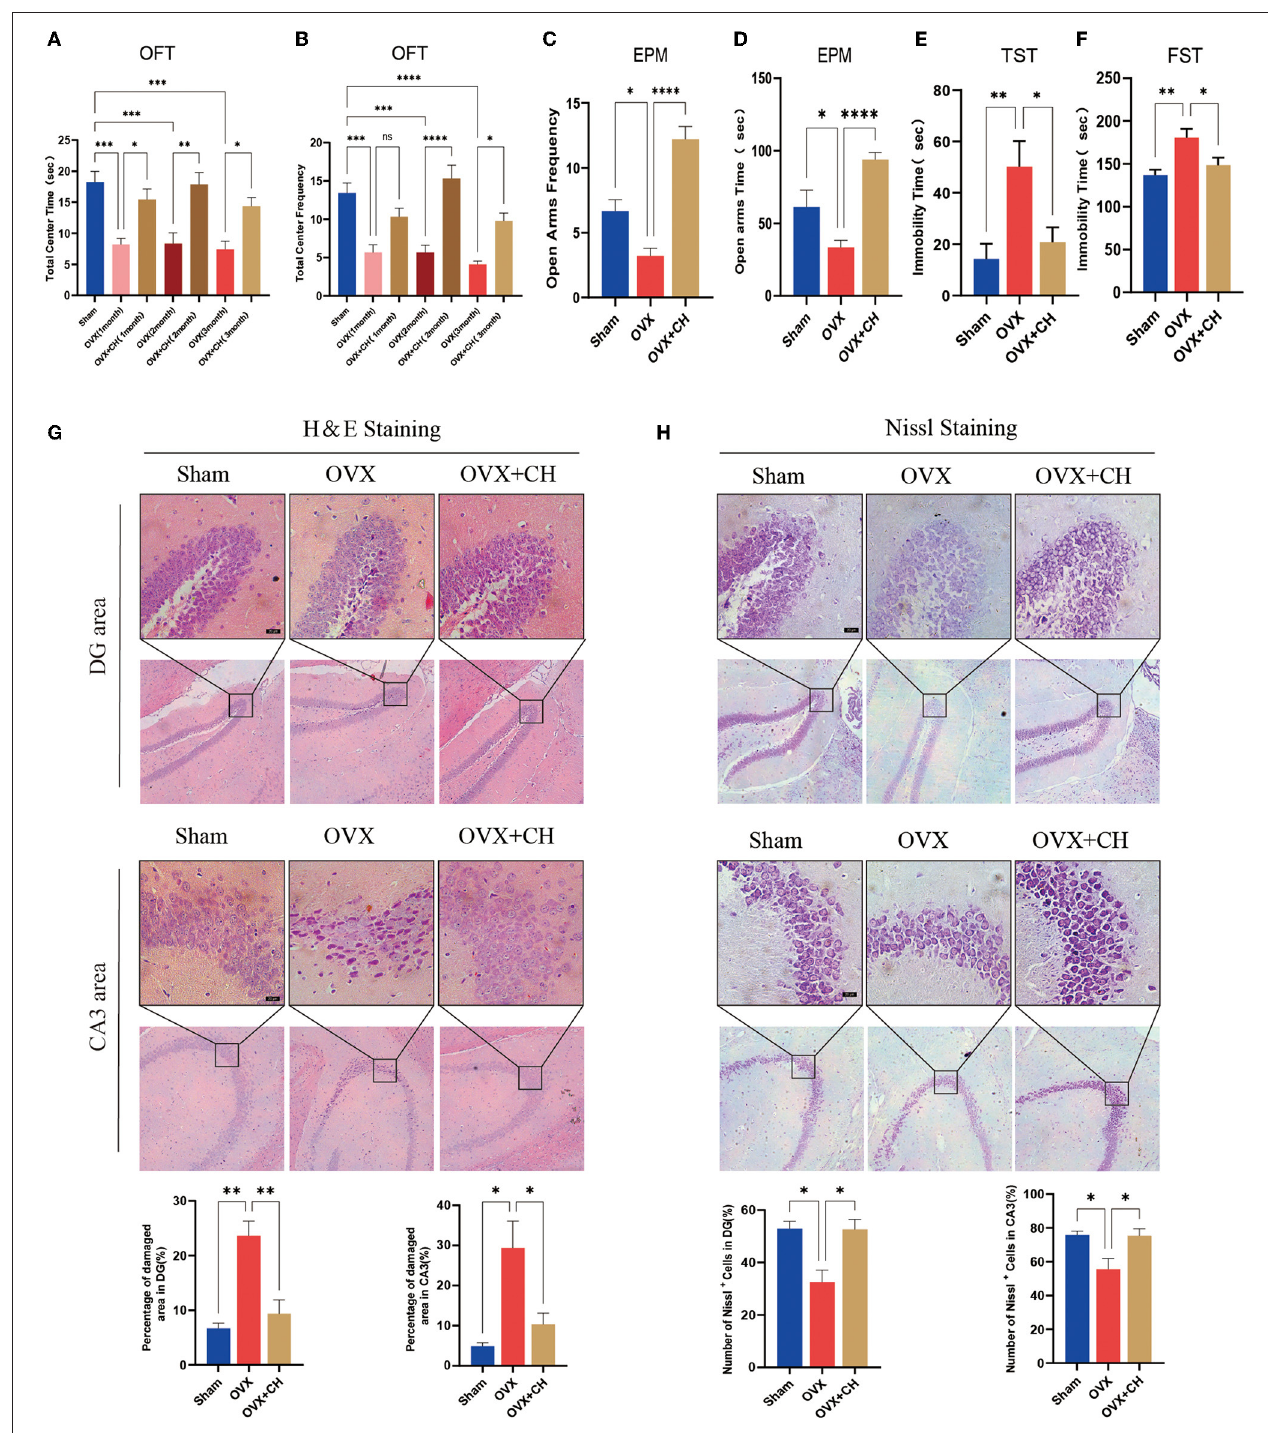
FIGURE 8 | Cohousing with P. histicola -treated mice alleviated the depression-like behaviors in OVX. (A) Central area time of OFT. (B) Transition times of OFT. (C) Total time in open arms of EPM. (D) Transition times in open arms of EPM. (E) Immobility time of TST. (F) Immobility time of FST. (G) H & E staining and its quantifications. Magnification 100 × and 400 × . Scale bar = 20 µ m. (H) Nissl staining and its quantifications. Magnification 100 × and 400 × . Scale bar = 20 µ m. Data are presented as means ± SEM ( n = 4/group). * p < 0.05, ** p < 0.01, *** p < 0.001, **** p < 0.0001.